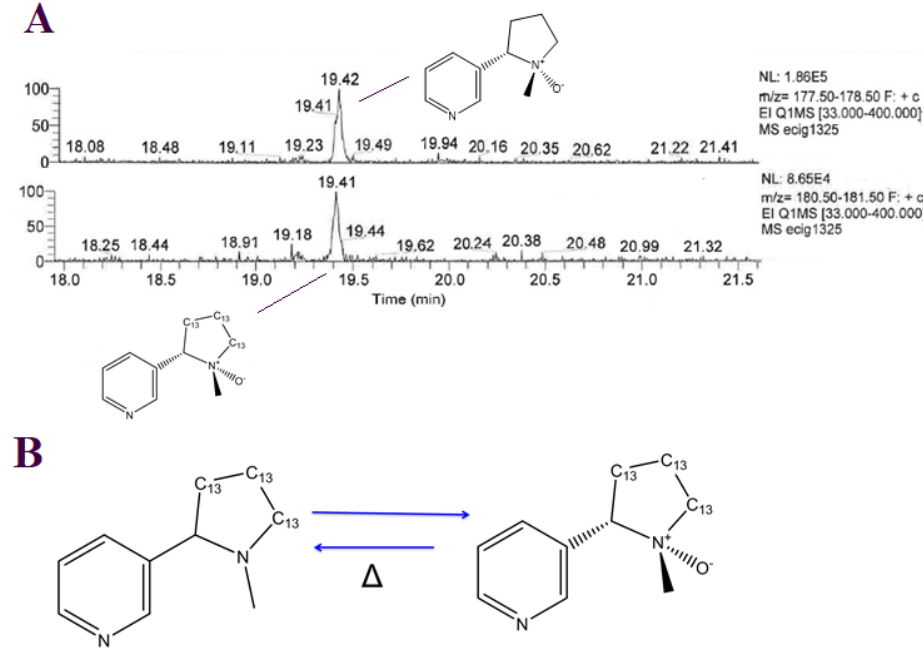
Figure 3. ( A ) . Extracted ion chromatograms of (1 ′ S 2 ′ S) nicotine-1 ′ -oxide (m/z 178) and (1 ′ S 2 ′ S) 13C 3 nicotine-1 ′ -oxide (m/z 181); ( B ) . Degradation and thermal rearrangement of 13 C 3 nicotine to (1 ′ S 2 ′ S) 13 C 3 nicotine-1 ′ -oxide.